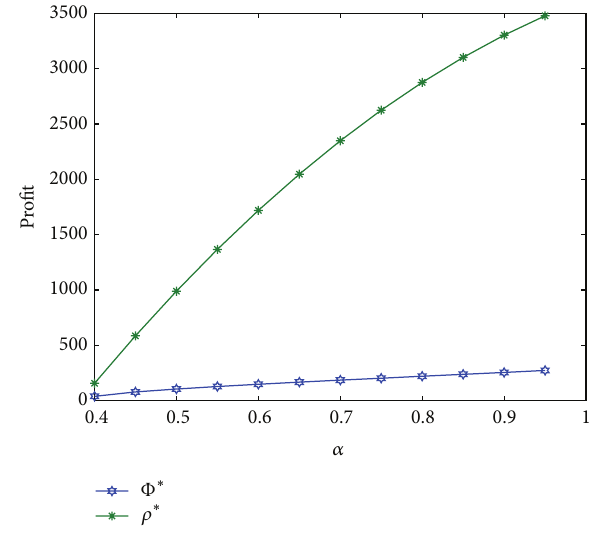
Figure 16: Impacts of 𝛼 on Φ ∗ and 𝜌 ∗ .